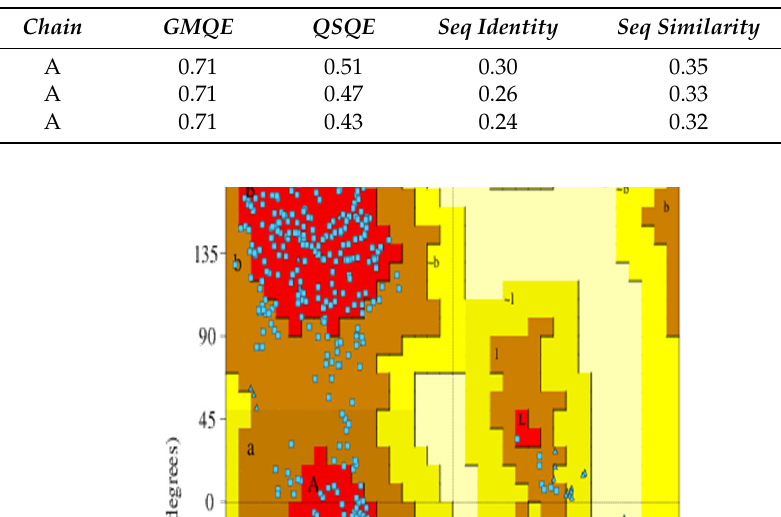
Table 1. Homology models generated using SWISS-MODEL.